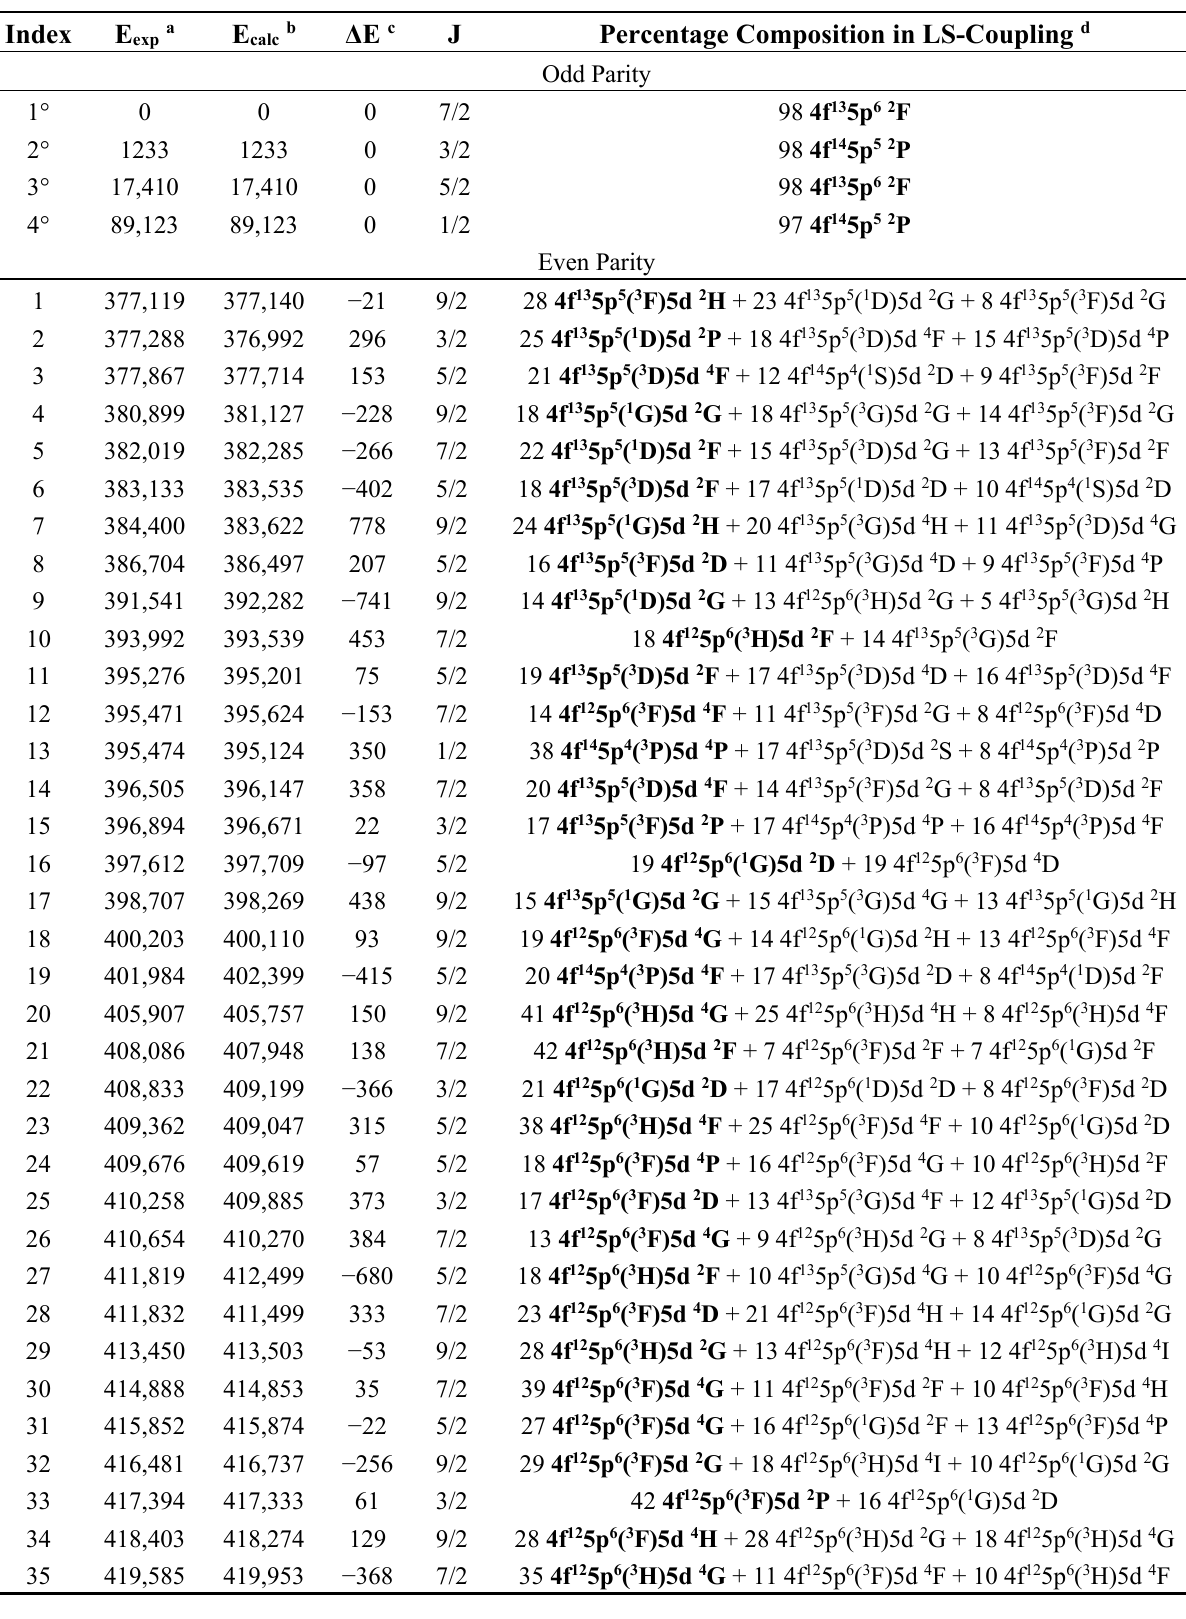
Table 2. Comparison between the energy levels computed in the present work and the experimentally known values available in seven times ionized tungsten (W VIII). Energies are given in cm − 1